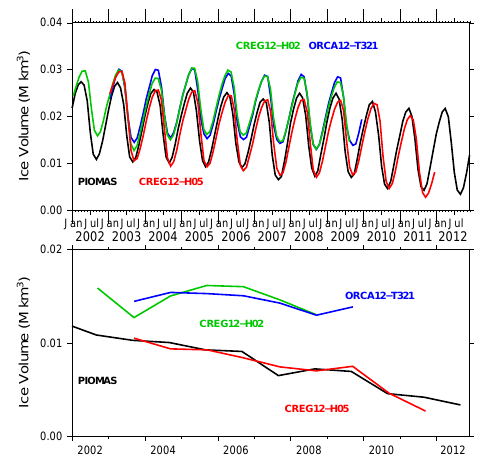
Figure 17. Monthly time series of total ice volume in the Arctic obtained from PIOMAS (black), the ORCA12 T321 run from Mer- cator Océan (blue), and CREG12 hindcasts H02 (green) and H05 (red). The top panel shows all months, while the bottom panel re- tains only September from each